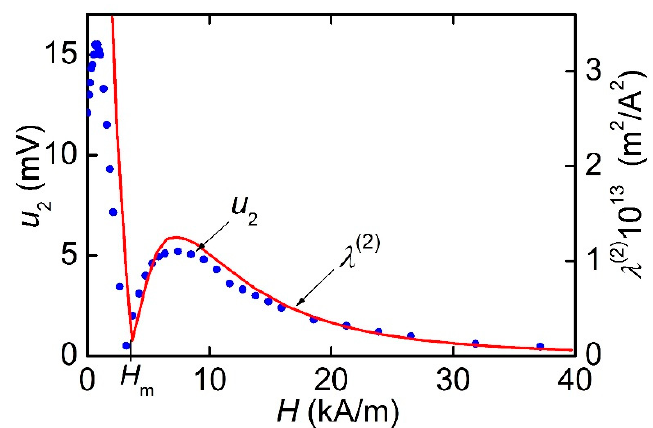
Figure 10. Dependence of the second harmonic amplitude u 2 on the constant magnetic field H in the М FC-PZT structure with T 1 = 250 µ m. The solid curve is the calculated field dependence of the nonlinear piezomagnetic coefficient λ (2) ( H ).